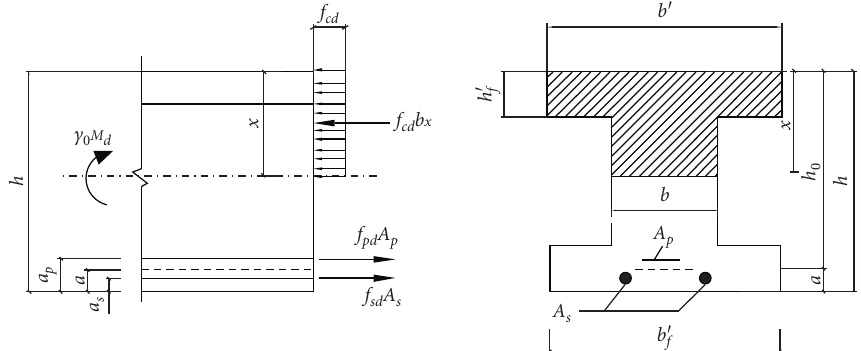
Figure 15: Equivalent rectangular stress figure of compression